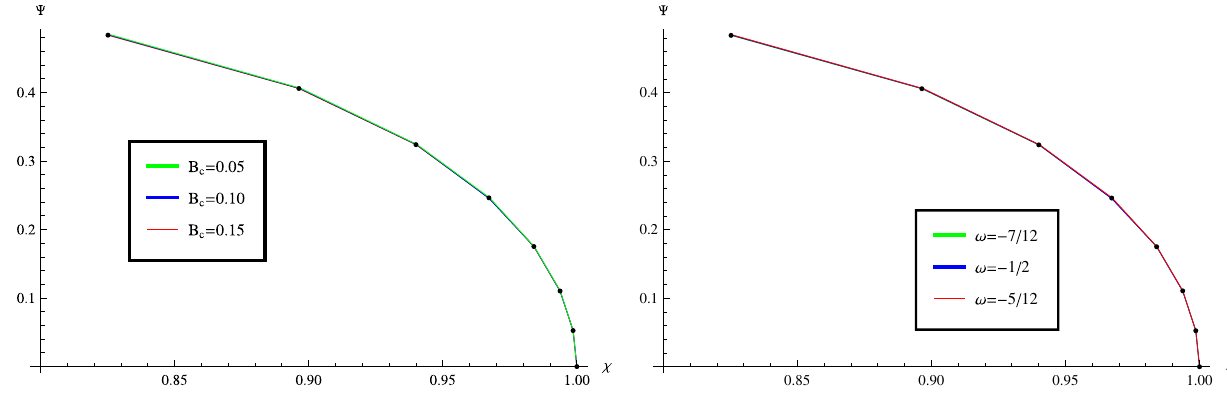
Fig. 4 The (cid:12)( T ) − x diagram for charged anti-de Sitter black holes with differential B c and ω . The left figure Q = 1 ,ω = − 1 / 2, the right figure Q = 1 , B c = 0 .